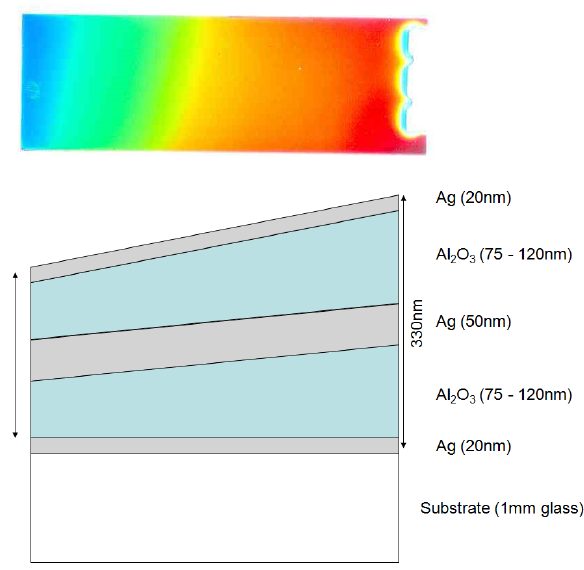
Fig. 13. Example of a wedged oxide/metal/oxide multilayer narrow- band transmission filter. Each point along such a five-layer stack, in which only the dielectrics are graded in thickness, transmits a bright band of light spanning a very small spectral range covering the complete visible spectrum [7].